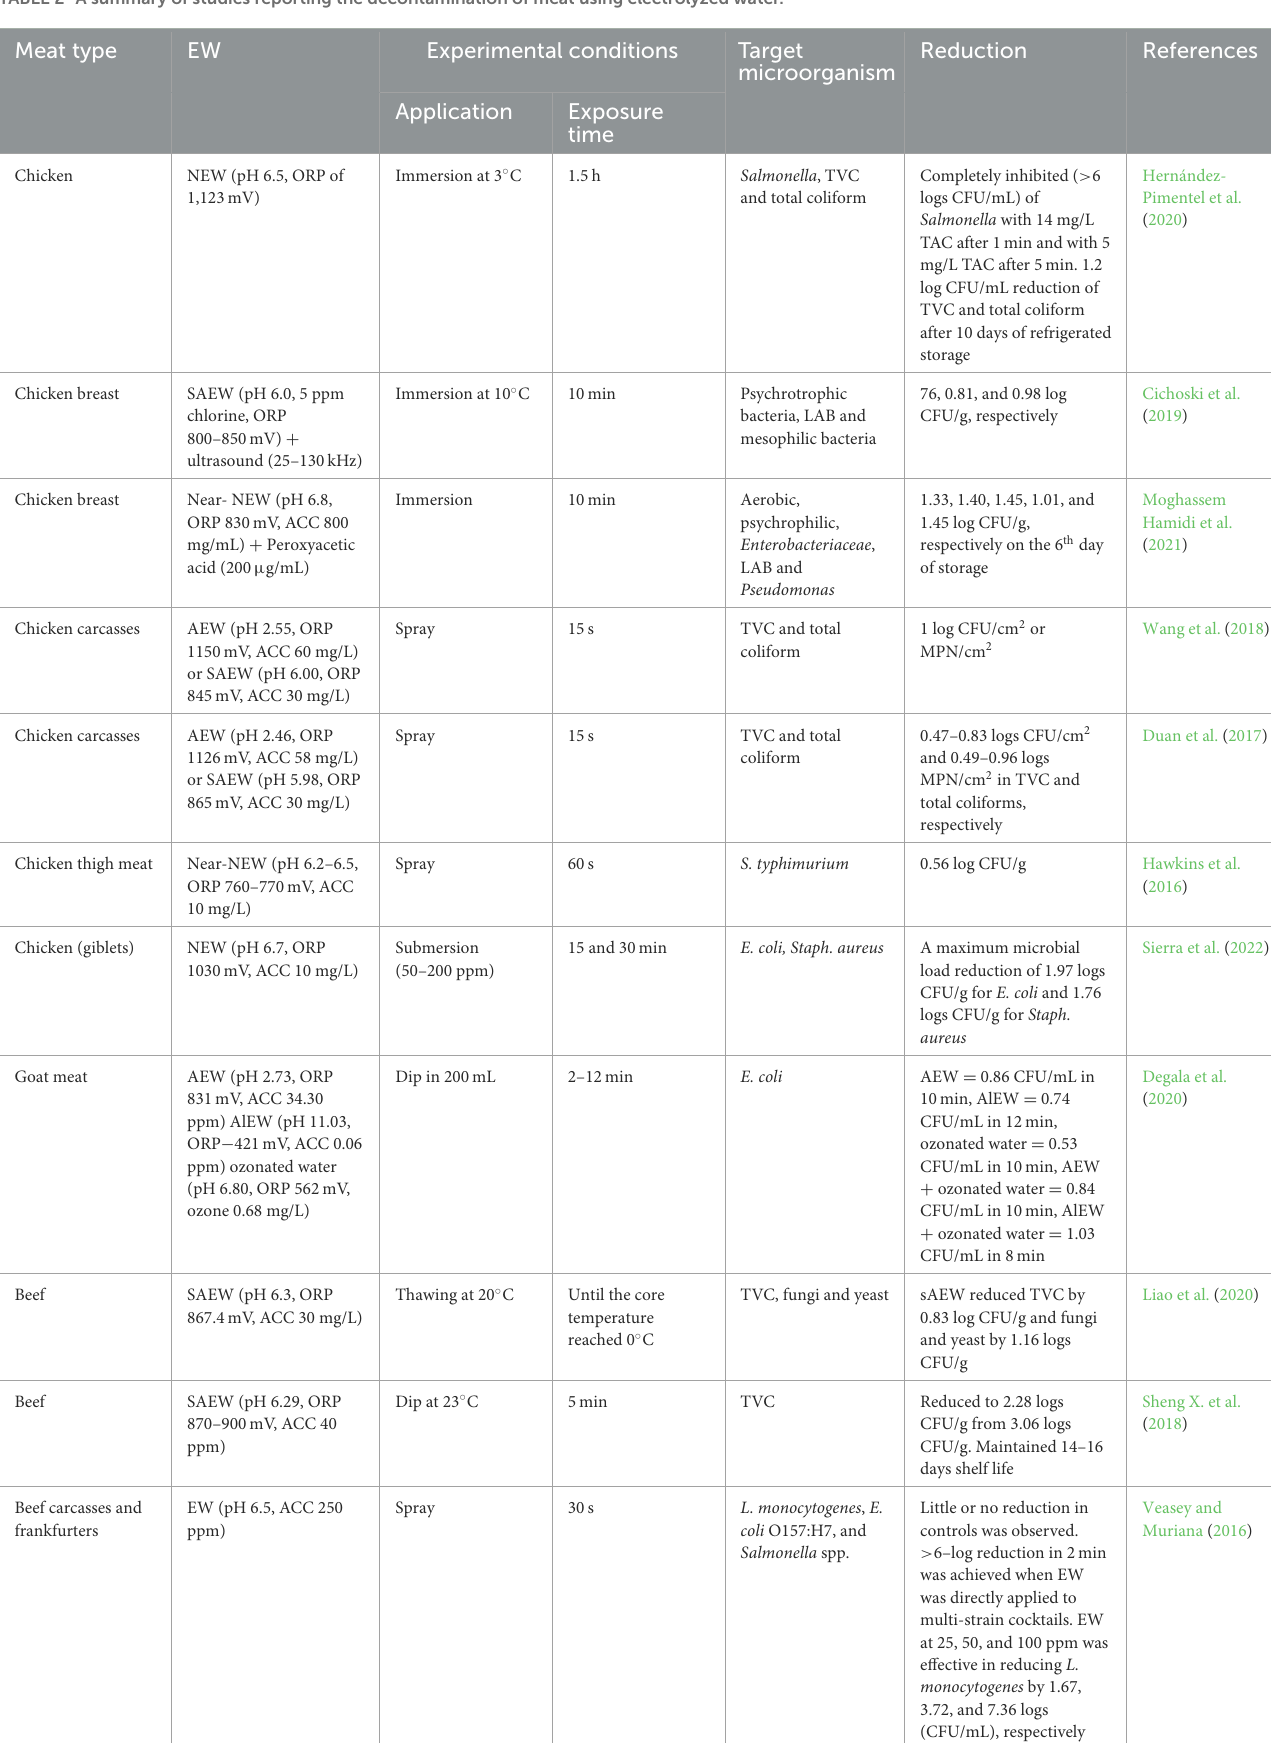
TABLE 2 A summary of studies reporting the decontamination of meat using electrolyzed